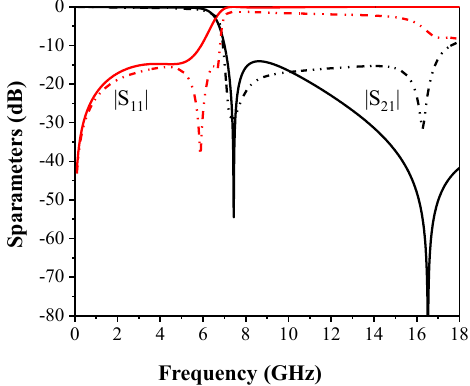
Figure 7: EM (solid line) and equivalent LC circuit (dash line) simulations of the proposed